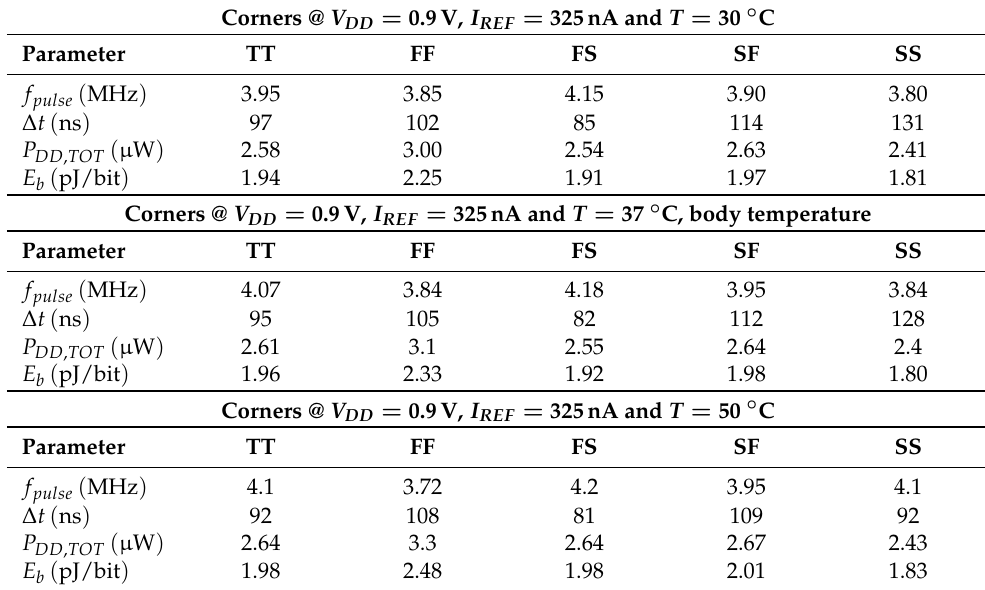
Table 4. Corner Simulations of the proposed BPSK demodulator @ V PZT = 4.5V and R PZT = 1.5 k Ω .